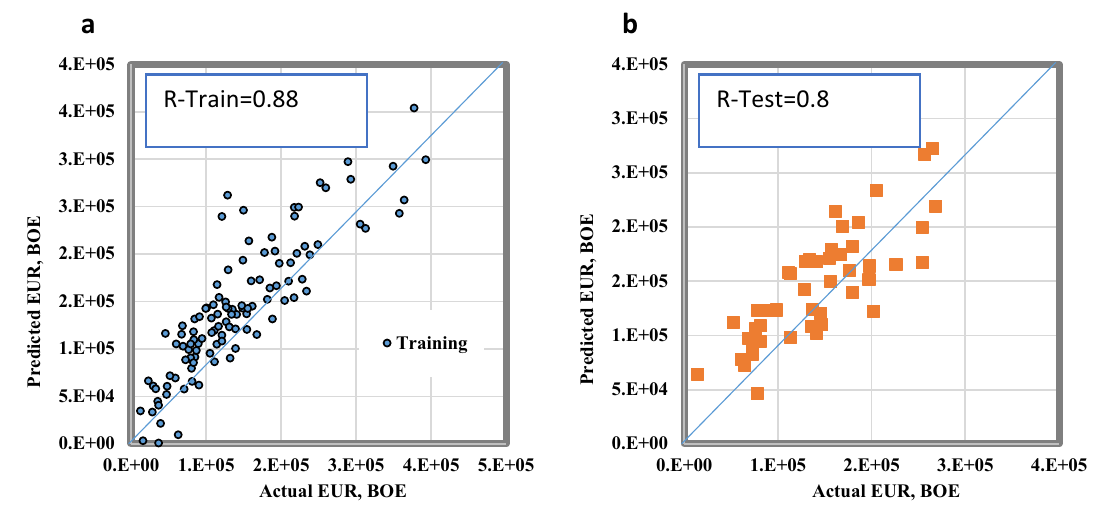
Fig. 5 The actual versus calculated EUR plot for the LR model in the case of a the training and b the testing data sets with including IP30 as an intermediate